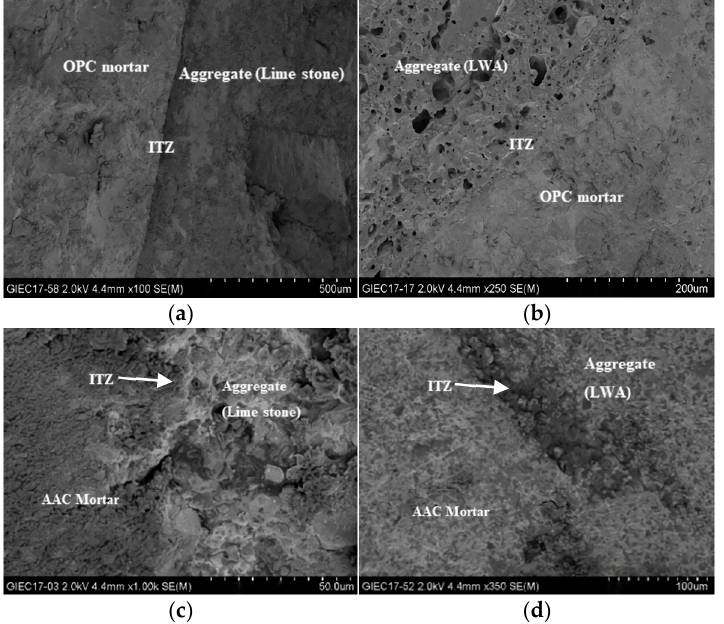
Figure 12. SEM image of the interfacial transition zone (ITZ) between the binder and aggregate: ( a ) NOPC; ( b ) LOPC; ( c ) NAAC; ( d )